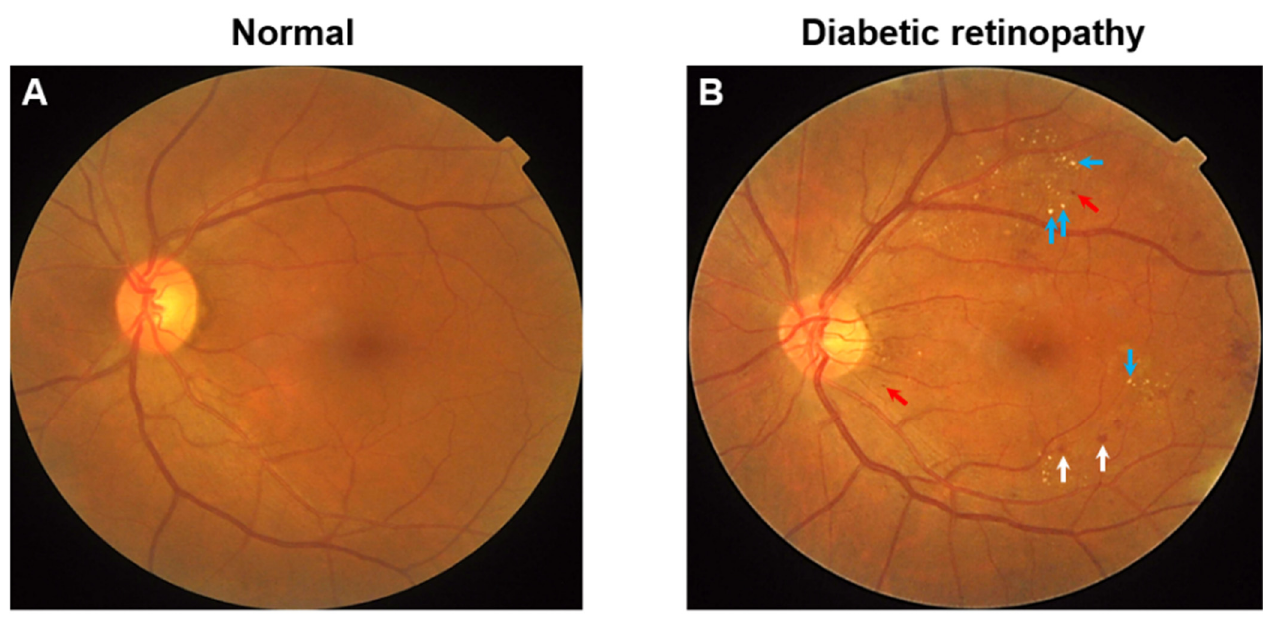
Figure 1. ( A ) Color fundus photograph of a diabetic individual without retinopathy. ( B ) Color fundus photograph of a diabetic individual with signs of moderate non-proliferative diabetic retinopathy. Notably, features include microaneurysms (red arrows), dot-and-blot hemorrhages (white arrows), and hard exudates (blue arrows, HE).